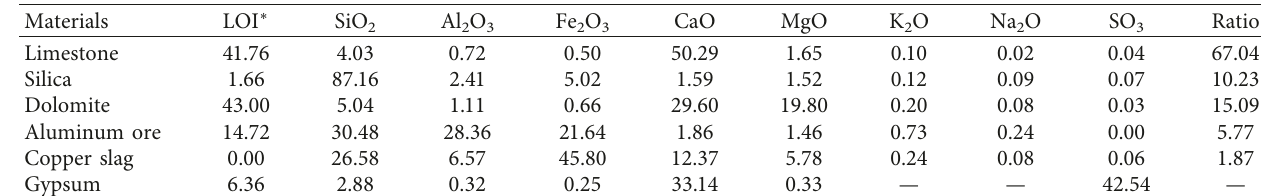
Table 1: Chemical compositions of raw materials (by weight, %).